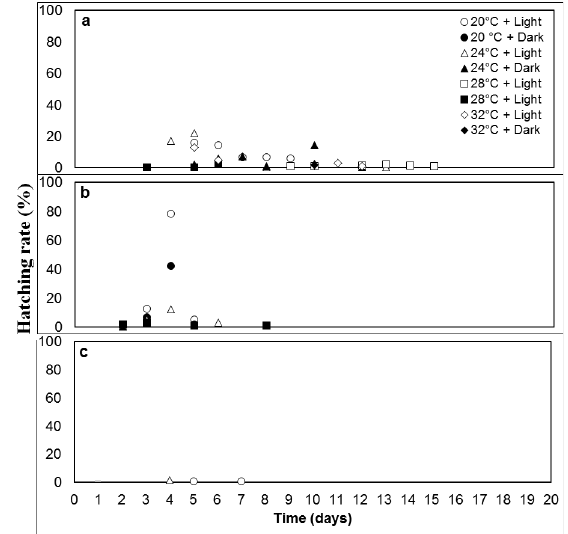
Figure 1 - Daily percentage of hatching of resting eggs at temperatures of 20 °C, 24 °C, 28 °C and 32 °C in the light (12 h photoperiod) and dark conditions. Pampulha lake ( a ) , Nado lake ( b ) and Jacaré lake ( c ).